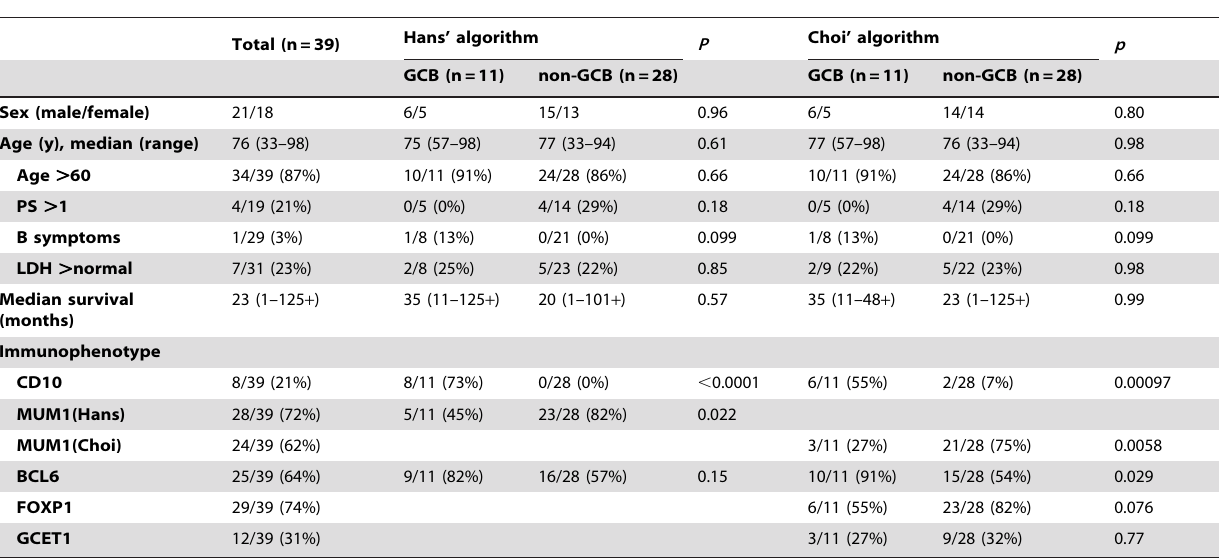
Table 3. Clinical and phenotypic characteristics of patients with GCB-type and non-GCB-type DLBCL.